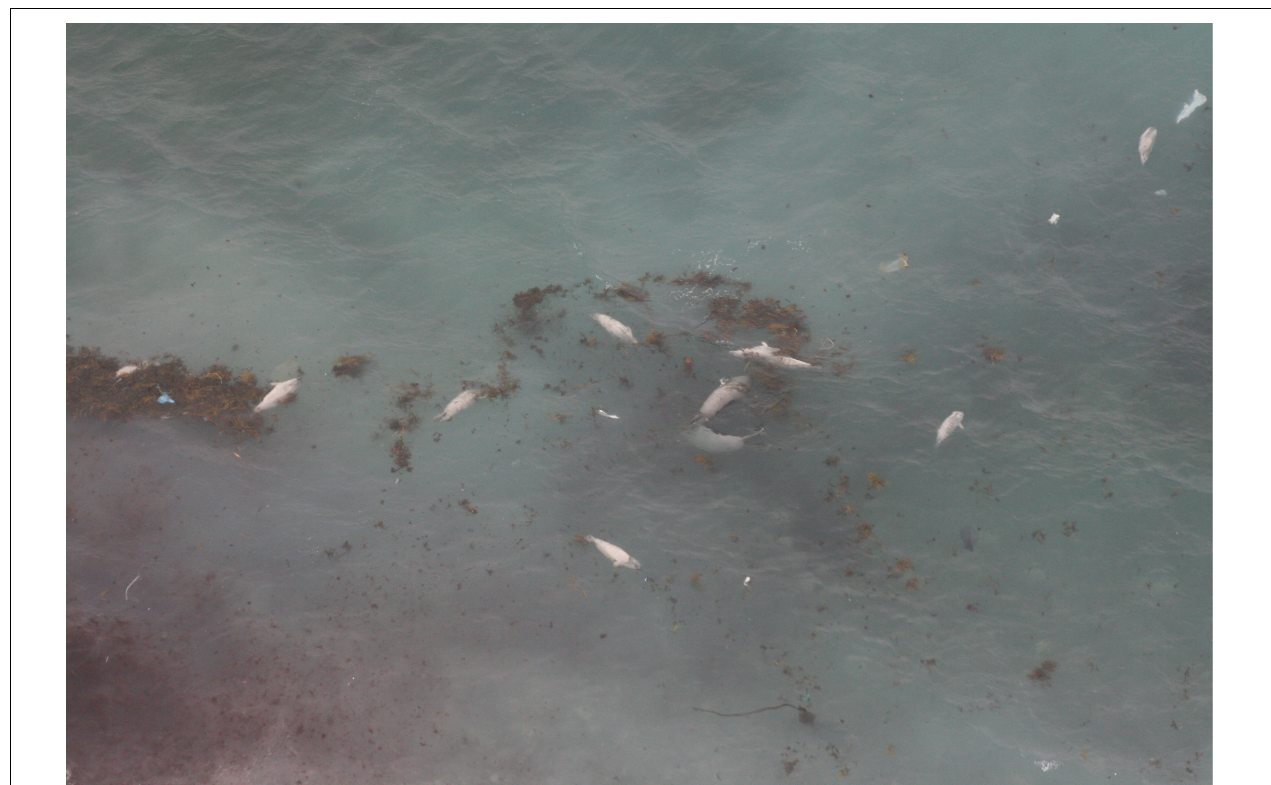
FIGURE 8 | Whitecoat harp seal pups that drowned after a storm destroyed the ice on which they had been born, northern Gulf of St. Lawrence March 2010. Photo credit: G.